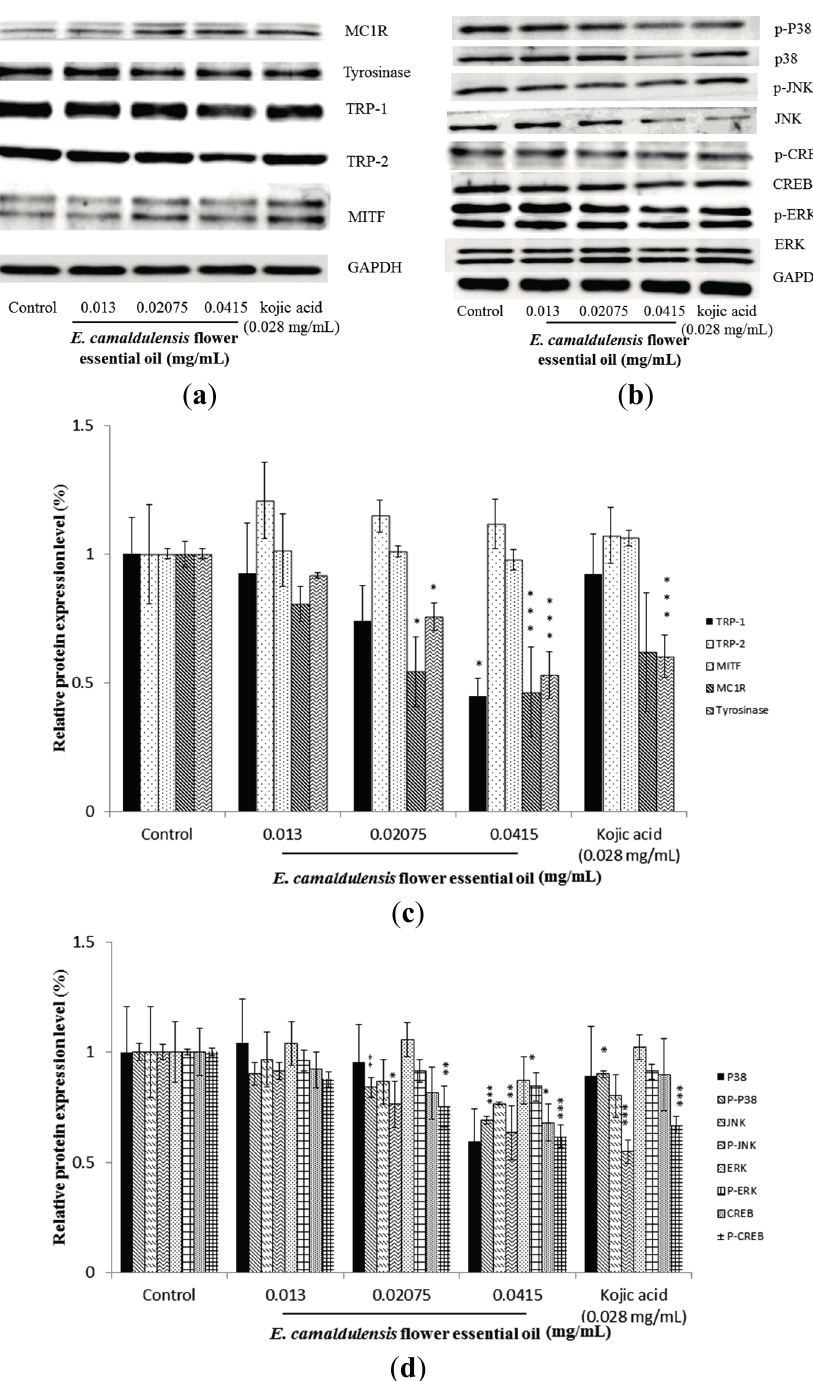
Figure 3. The effect of E. camaldulensis flower essential oil on melanogenesis-related protein expression and signaling pathways. B16F10 cells were cultured with α -MSH (100 nM) for 24 h, and then treated with various concentrations of essential oil (0.013, 0.02075, 0.0415 mg/mL) or kojic acid (200 μ M) for another 24 h. The expression of cellular MITF, tyrosinase, TRP-1 and TRP-2 ( a ) or regulators of signaling pathways ( b ) was analyzed by Western blotting; The relative amounts of MITF, TRP-1, tyrosinase, TRP-2 and MC1R ( c ) or phosphorylated proteins (p-JNK, p-ERK and p-p38) ( d ) compared to the total GAPDH were calculated and analyzed using Multi Gauge 3.0 software, and the values represent the mean of triplicate experiments ± standard deviations. * p < 0.05; ** p < 0.01; *** p <